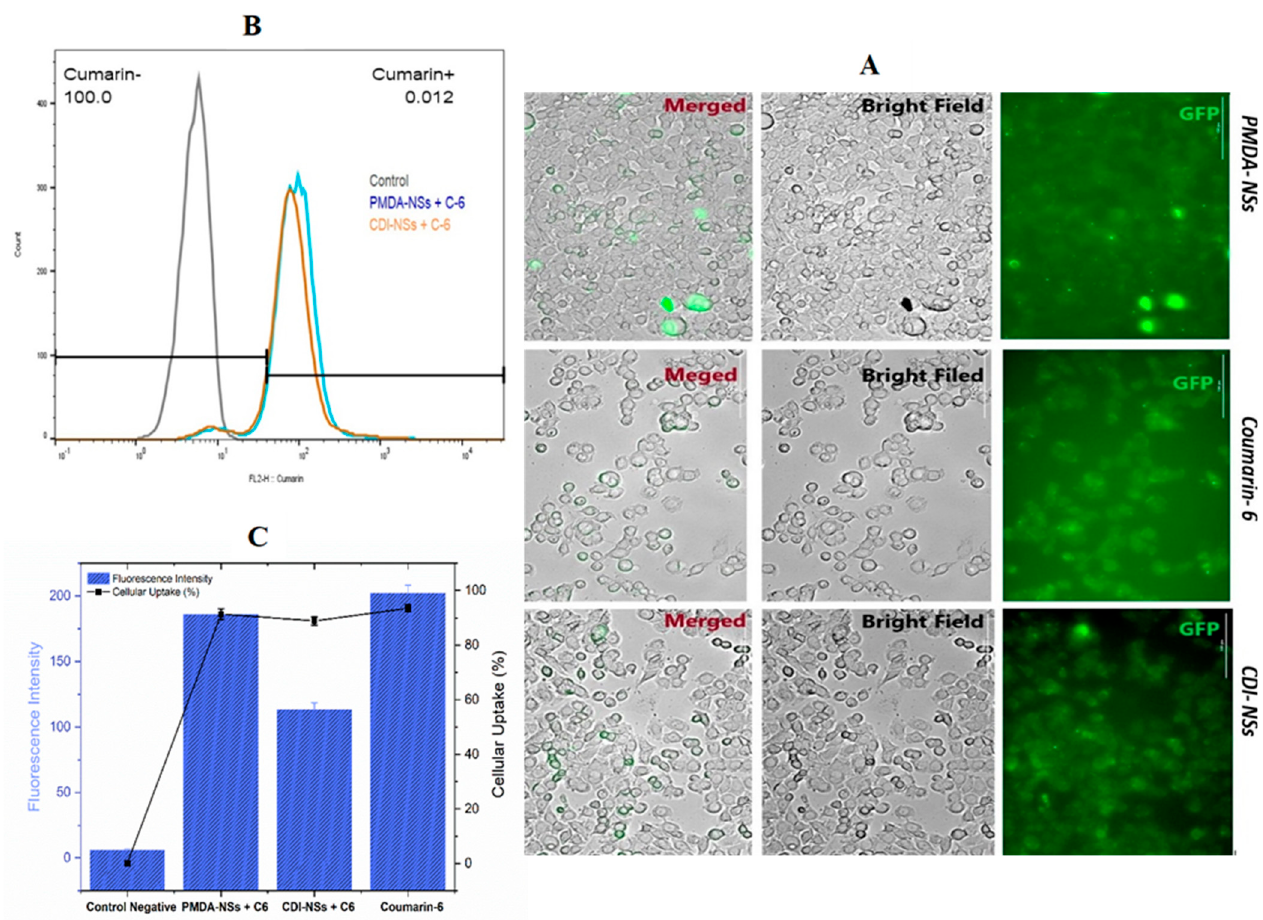
Figure 4. Uptake of coumarin-6 labeled CDNSs on HT-29 cells at 37°C for 4 h was observed and investigated by fluorescent microscopy and flowcytometry. ( A ) was observed by fluorescence microscope. ( B ): Flowcytometry assay, ( C ): Mean of Fluorescence Intensity of HT-29 cells by flowcytometry assay. Data are expressed as mean ± SD ( n = 3). One-way ANOVA analyses was used.